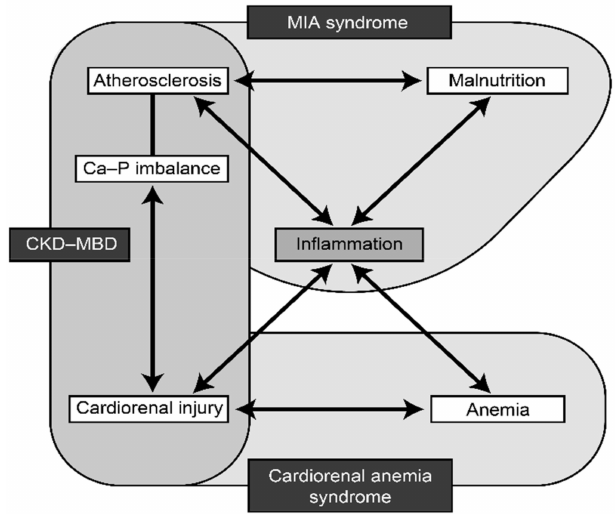
Figure 1. Interaction between malnutrition, inflammation, and atherosclerosis in chronic kid- ney disease [22]. MIA: malnutrition–inflammation–atherosclerosis; Ca: Calcium; P: Phosphorus; CKD-MBD: chronic kidney diseases-related mineral and bone